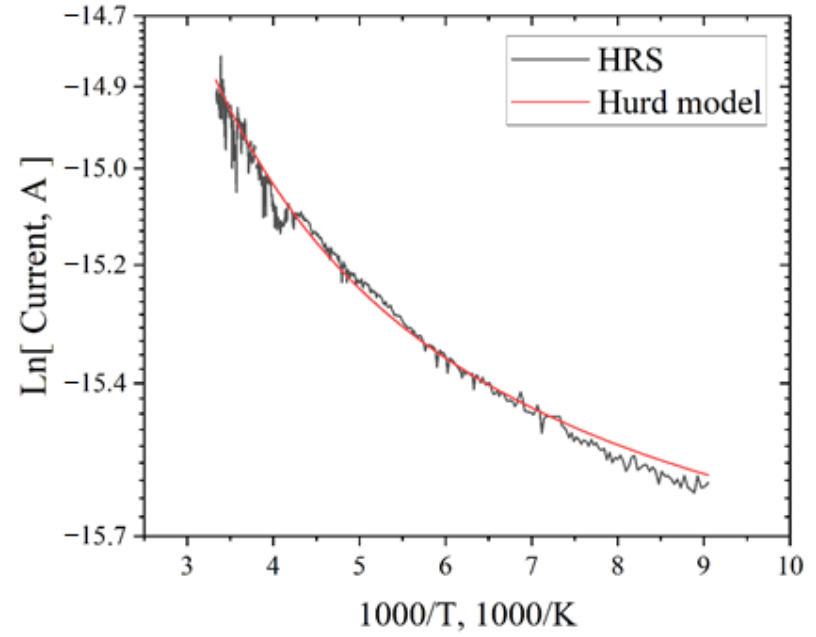
Figure 10. Dependence of current on temperature for the HRS state ( black ) and approximation curve by the Hurd model ( red ) for C12A7:e − .